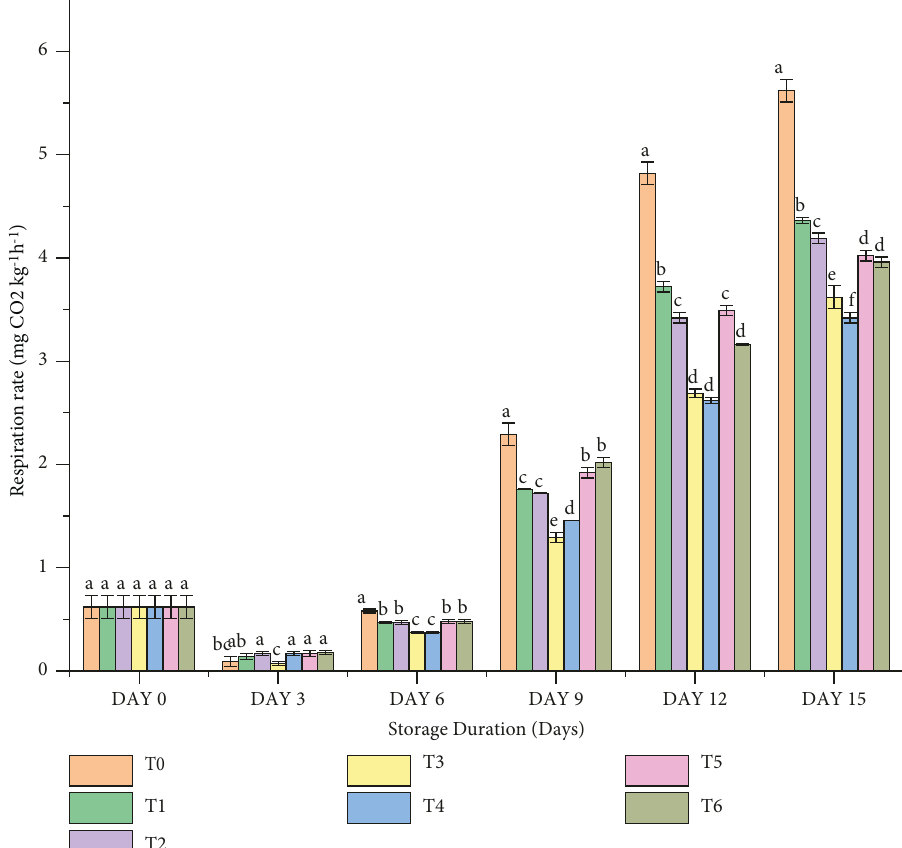
Figure 1: Effect of chitosan coating and cinnamon essential oil on the respiration rate of pomegranate arils during storage at 4 ± 1 ° C. Vertical bars represent the mean ± SD of 3 replicates. Error bars with different letters on the same storage period show a significant difference ( P ≤ 0 . 05). T0 � control; T1 � 1% chitosan+0.25% oil; T2 � 1% chitosan+0.5% oil; T3 � 2% chitosan+0.25% oil; T4 � 2% chitosan+0.5% oil; T5 � 3% chitosan+ 0.25% oil; T6 � 3% chitosan+0.5%